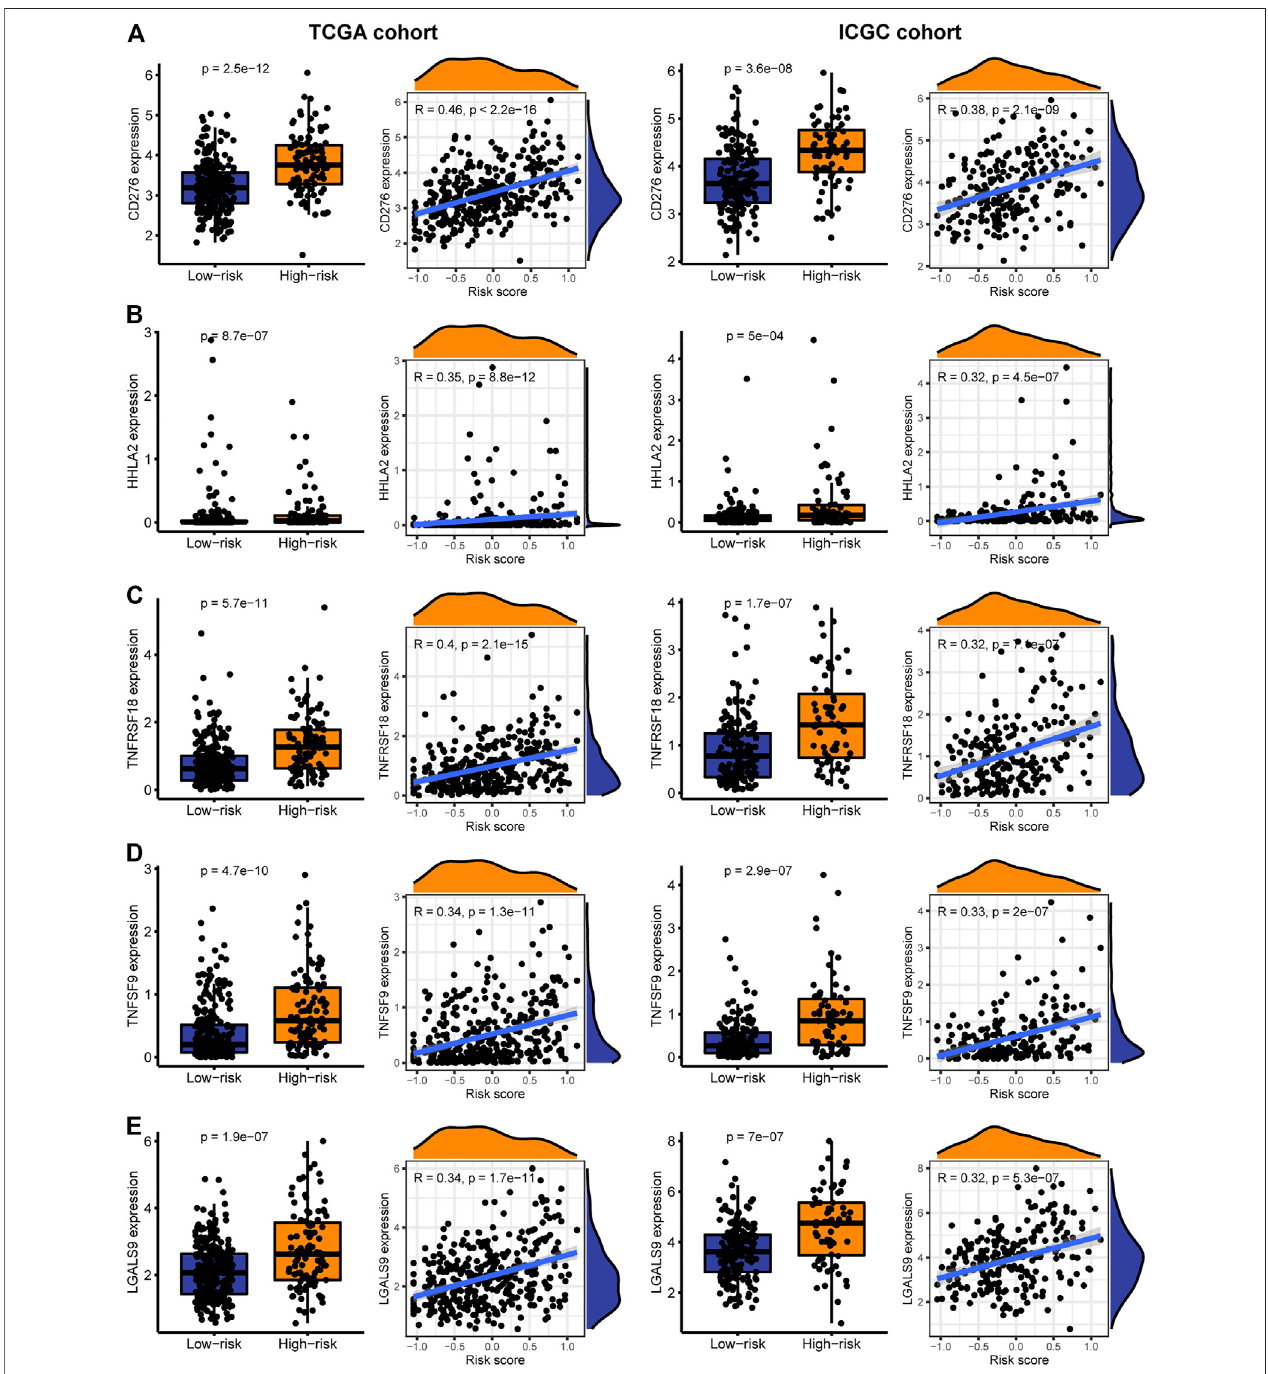
FIGURE 5 | The expression and correlation between immune checkpoints in high and low-risk patients in the TARGET and ICGC cohorts. (A) CD276 (B) HHLA2 (C) TNFRSF18 (D) TNFSF9 (E) LGALS9.